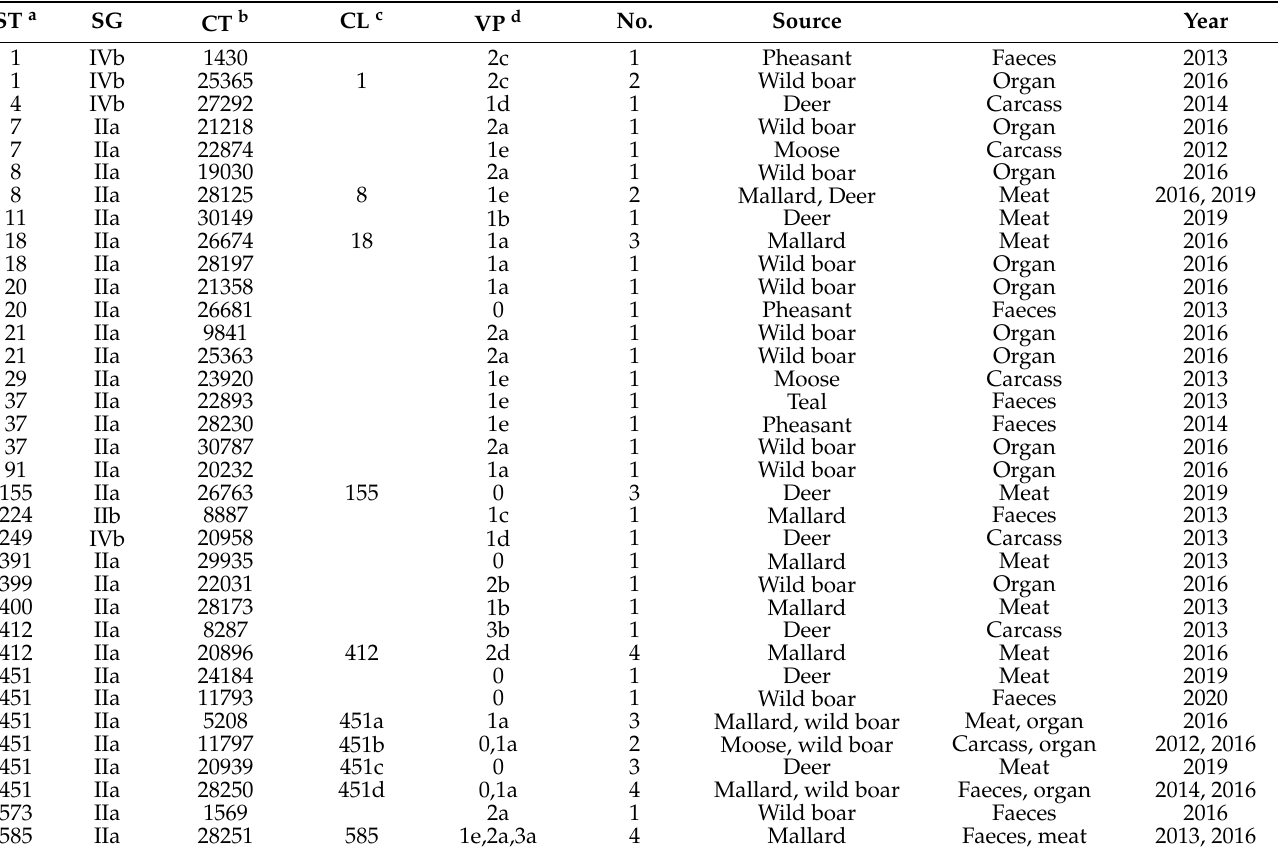
Table 4. Distribution of different serogroups (SGs), MLST (STs) and cgMLST (CTs) profiles, clusters (CLs) and virulence profiles (VPs) among 55 Listeria monocytogenes isolates from hunted game and game meat between 2012 and 2020 in